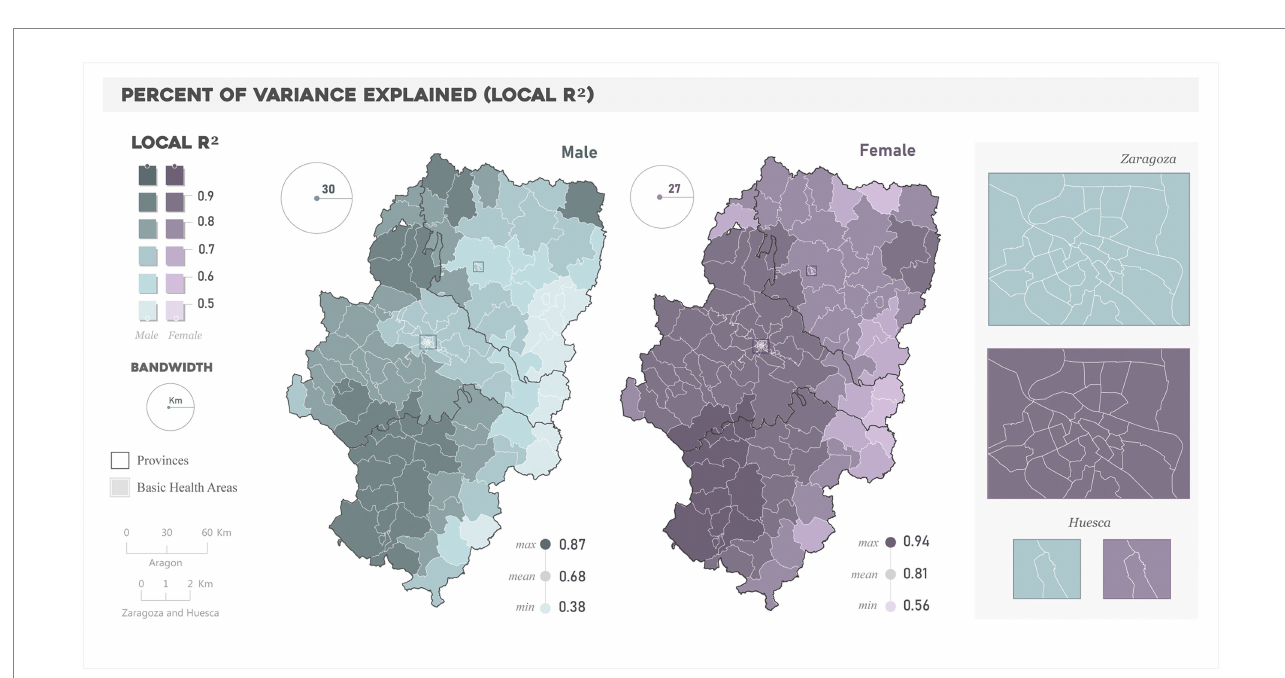
FIGURE 4 Spatial distribution of the Local R2 in the “All years”